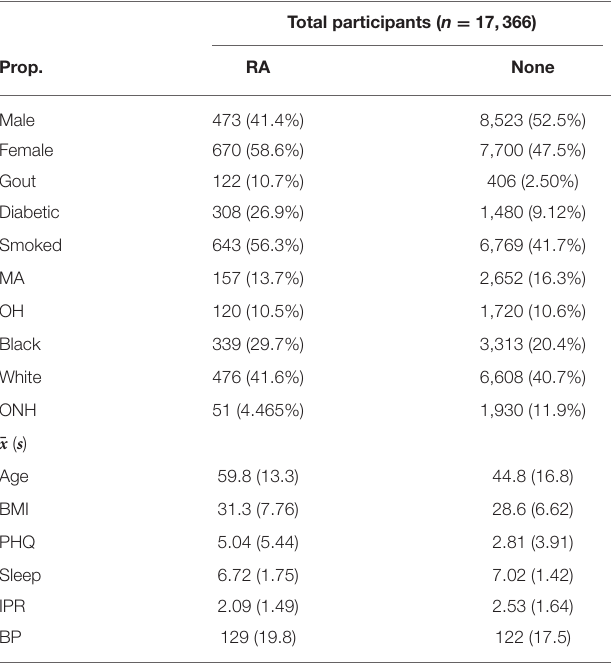
TABLE 1 | Summary characteristics of demographics and risk factors for RA and no arthritis (None) group in the study population. Total participants ( n = 17,366)